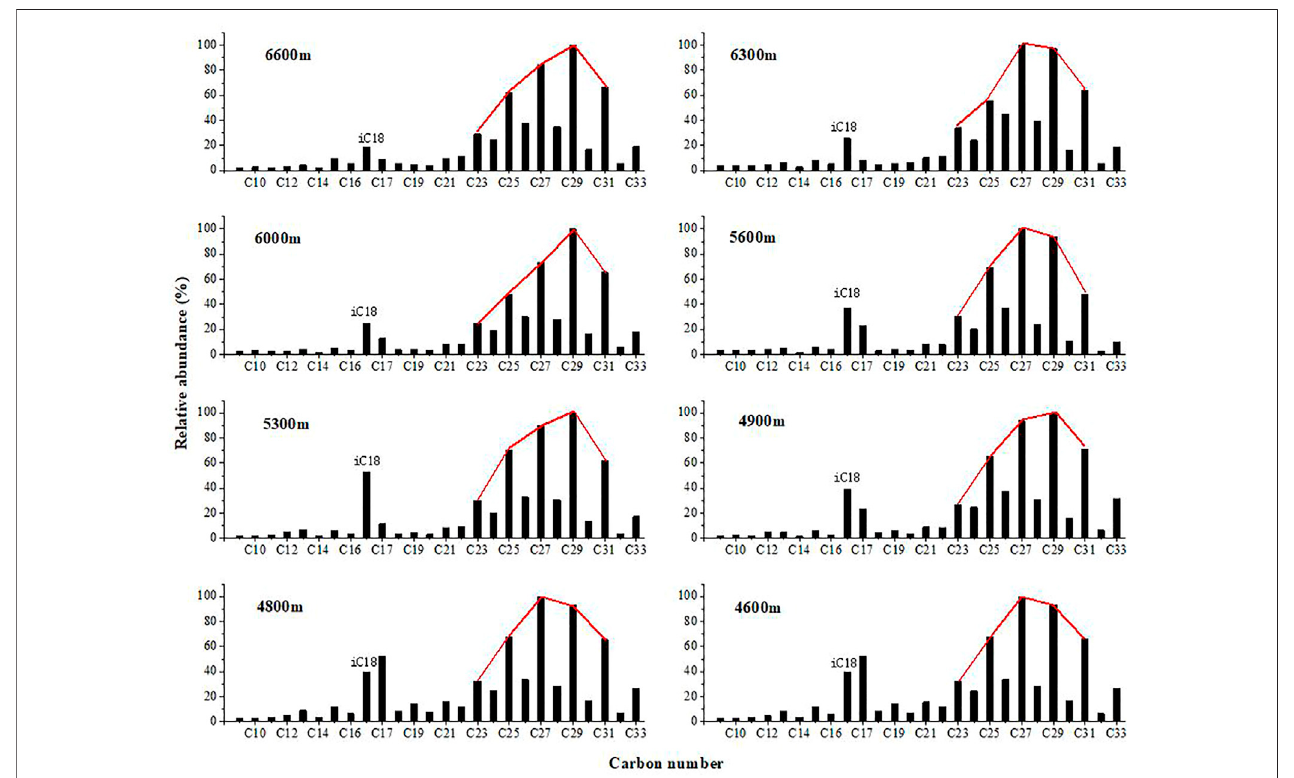
FIGURE 3 | Distributions of n -alkane-2-ones in the sediment samples from Gongga Mountain.